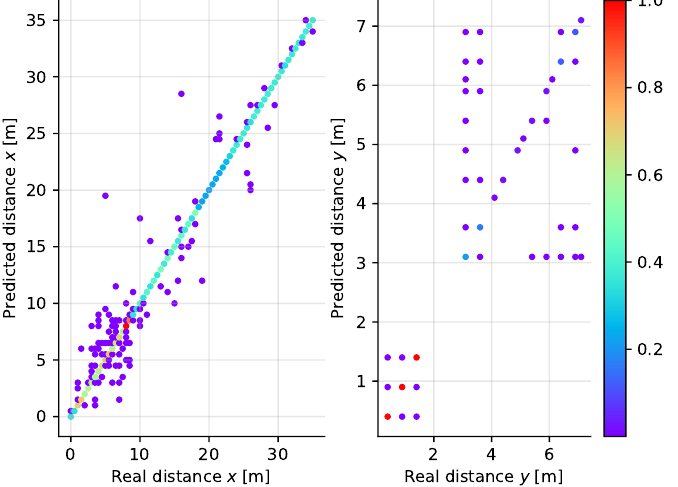
Figure 17. Scatter plot diagram of the real and predicted distance along the X ( left ) and Y ( right ) axes for the SVM classifier applied to two-dimensional